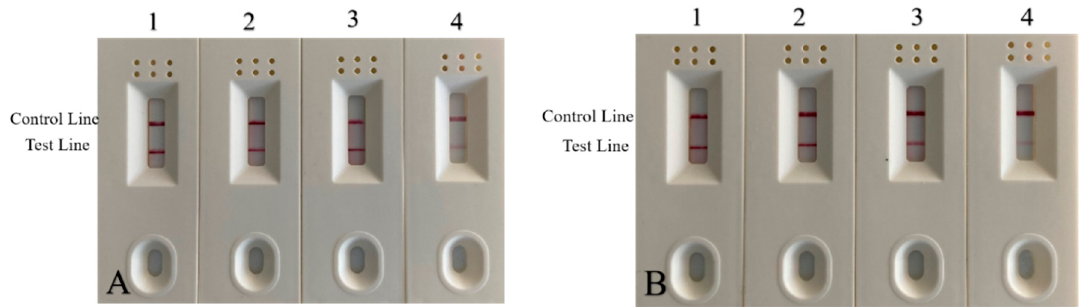
Figure 12. Strip test results of beef and mutton mixed with a duck by volume. ( A ) Results of beef and duck mixture. 1: 50% duck + 50% beef; 2: 10% duck + 90% beef; 3: 5% duck + 95% beef; 4: 1% duck meat + 99% beef. ( B ) Ratio results of mutton and duck mixture. 1: 50% duck + 50% mutton; 2: 10% duck + 90% mutton; 3: 5% duck + 95% mutton; 4: 1% duck meat + 99% mutton meat.